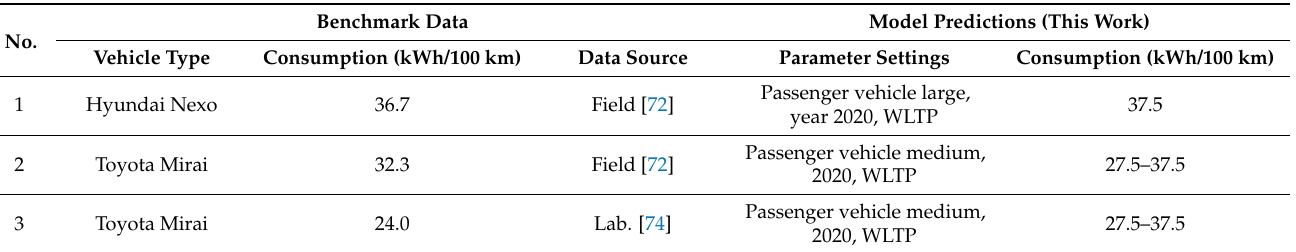
Table 17. Comparison between experimental data on FCEV consumption from the literature and this